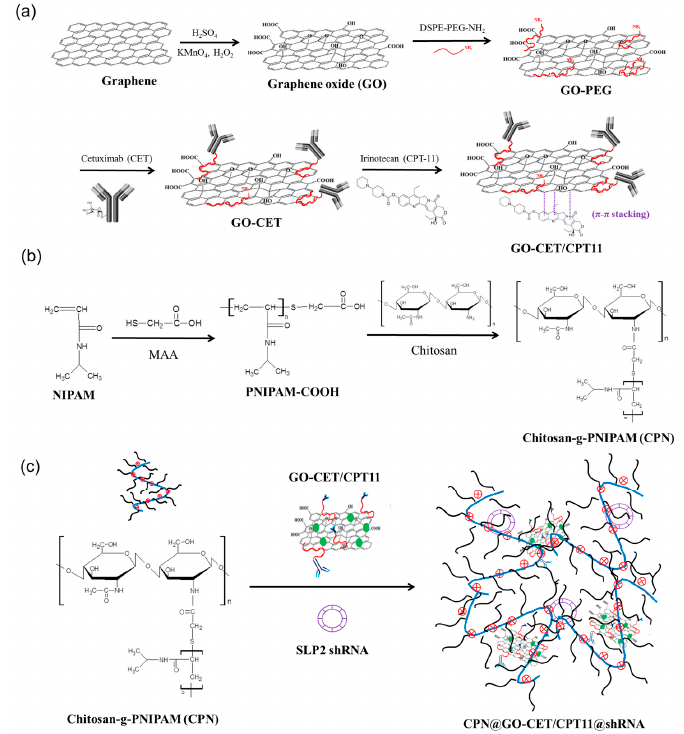
Figure 1. The flow diagram for synthesizing irinotecan (CPT-11) to cetuximab (CET)-conjugated graphene oxide (GO) (GO-CET / CPT11) for co-entrapment with stomatin-like protein 2 (SLP2) short hairpin RNA (shRNA) in chitosan-g-poly( N -isopropylacrylamide) (CPN). ( a ) GO produced by the modified Hummers method was modified with N -(aminopropyl polyethyleneglycol)carbamyl-distearoylphosphatidyl- ethanolamine 1,2-distearoyl-sn-glycero-3-phosphoethanolamine- N -[amino(polyethyleneglycol)]